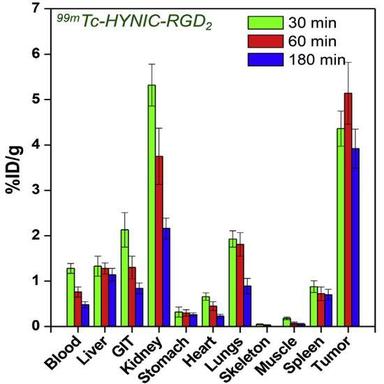
Biodistribution study in C57BL/6 mice bearing melanoma tumors after the administration of 99mTc-HYNIC-RGD2 prepared using 99mTc obtained from the 99Mo/99mTc generator.